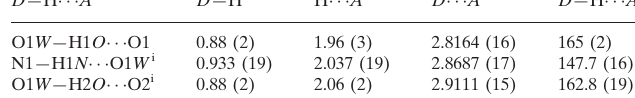
Hydrogen-bond geometry (A˚ , (cid:2) ). D —H (cid:4)(cid:4)(cid:4)